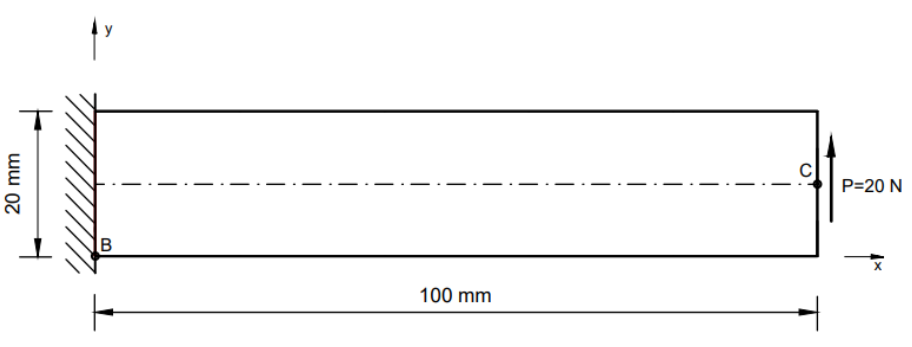
Figure 3. Structure 1: Cantilever beam.